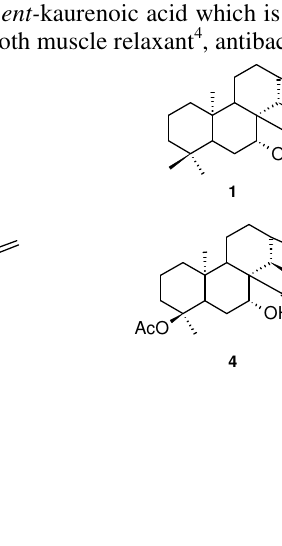
Figure 1. ent -kaurenoic acid and kaurane